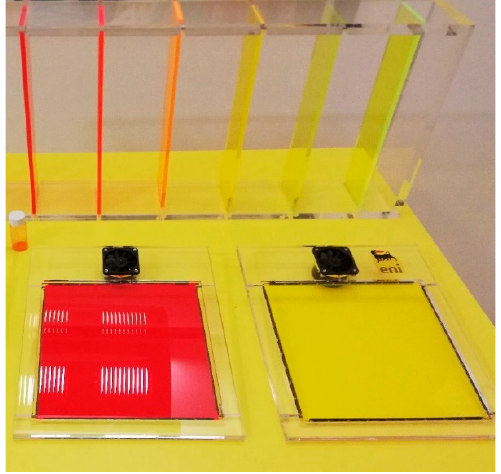
Figure 2. Different LSC modules and